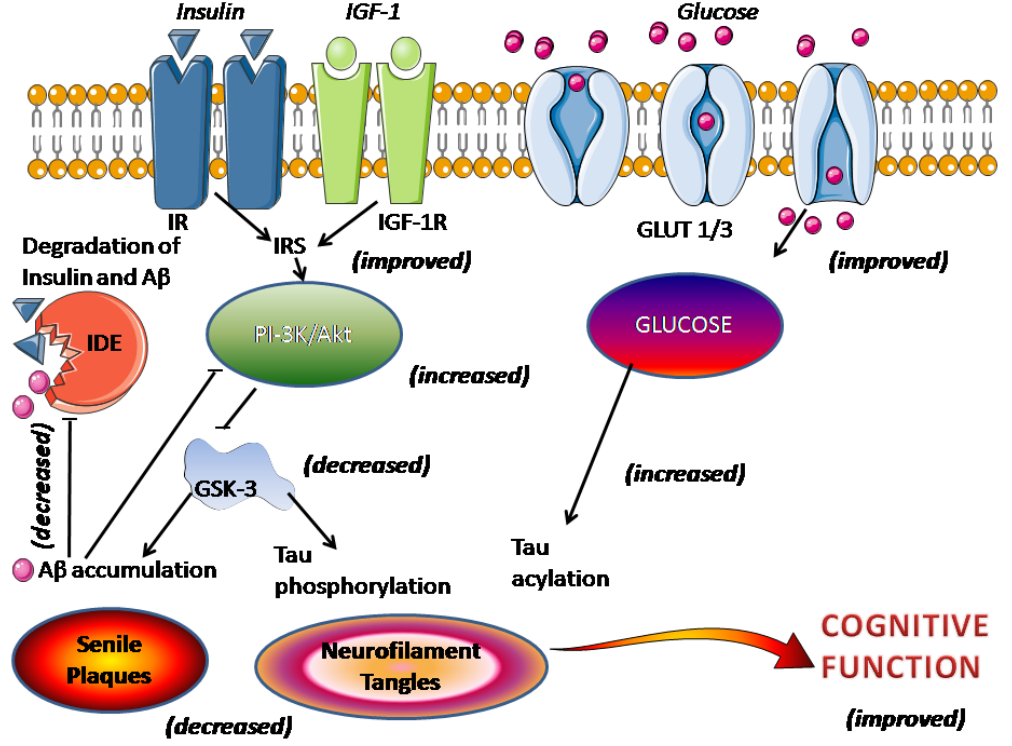
Figure 1. Effect of melatonin on impaired brain insulin signaling in AD. The figure schematizes the processes linking impaired insulin/insulin receptor with senile plaques and neurofibrillary tangles. In parentheses, the demonstrated action of melatonin as discussed in the